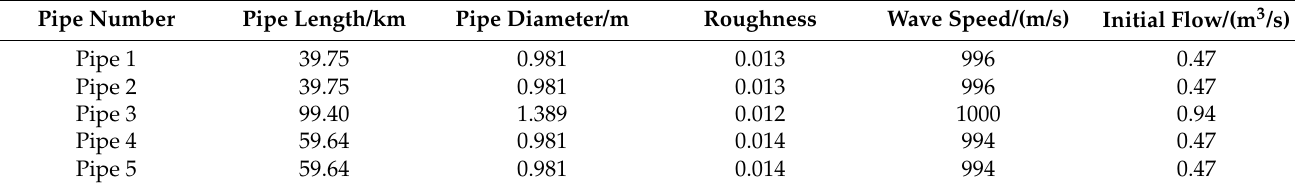
Figure 7. Schematic diagram of the long-distance water pipeline. Table 2. The pipeline model parameters.